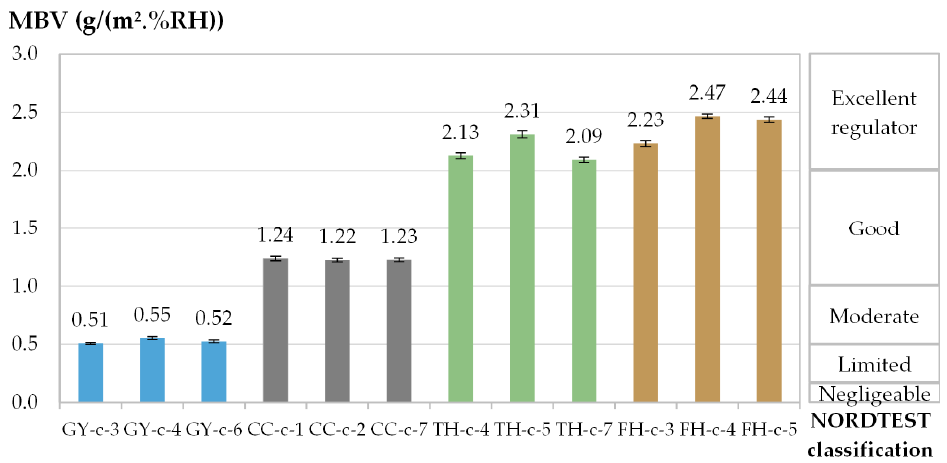
Figure 7. Average MBV [g/(m 2 .%RH)] and standard deviation obtained for each specimen per material along test 1 and NORDTEST classification [2].